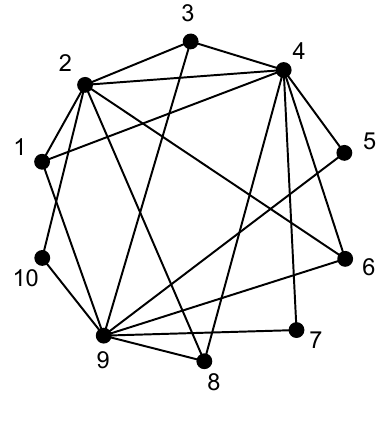
Figure 11. Coding graph at Node O in Experiment